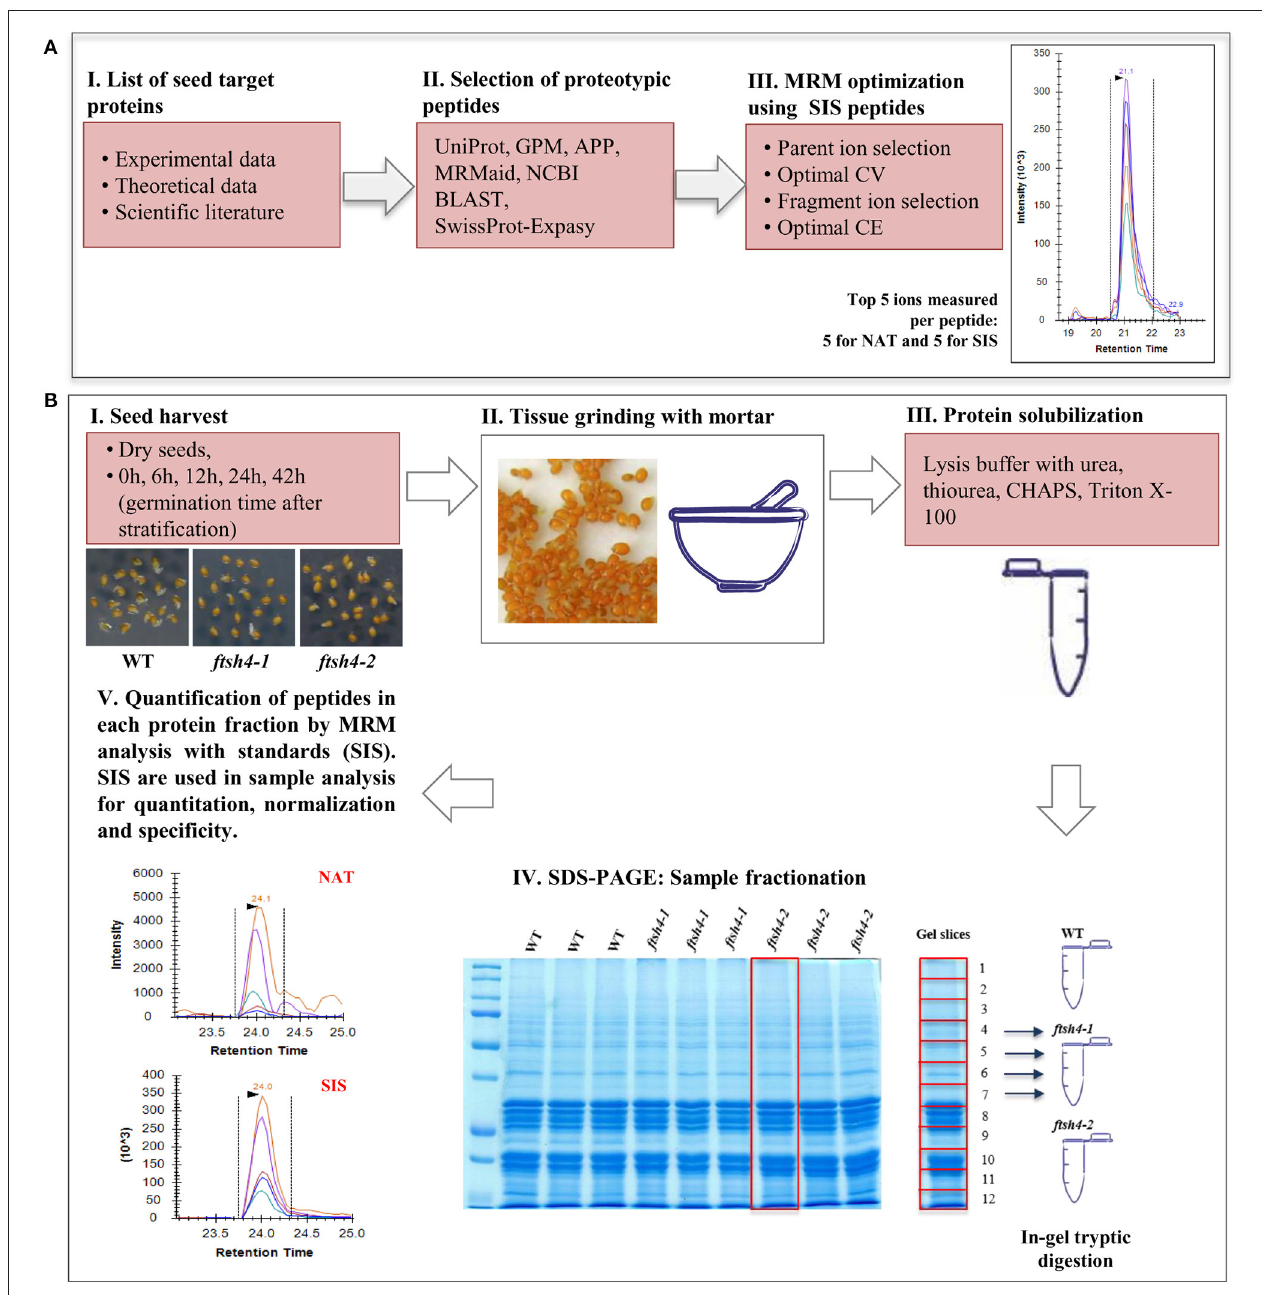
FIGURE 1 | Schematic experimental workflow of the MRM assay of Arabidopsis seed mitochondrial proteins. (A) Selection of proteins of interest, design of the peptides specific for the target protein and optimization of the MRM method. (B) MRM analysis of seed mitochondrial proteins: I, II, III—collection of the seed samples from wild-type and ftsh4 mutants, protein extraction and solubilization. IV, Fractionation of the total seed protein extracts (50 µ g) of WT, ftsh4-1 and ftsh4-2 from each studied stage (DS, 0, 6, 12, 24, and 42h) via 12% SDS-PAGE. Preparation of the samples for quantitative mass-spectrometry analysis. V,Quantification of the selected seed mitochondrial proteins by MRM peptide analysis with standards (SIS). CV, cone voltage; CE, collision energy; NAT, natural peptide; SIS, stable-isotope labeled standard peptide analog. More details on the survey design of the experiment are given in the main text of the section Materials and Methods as well as Results